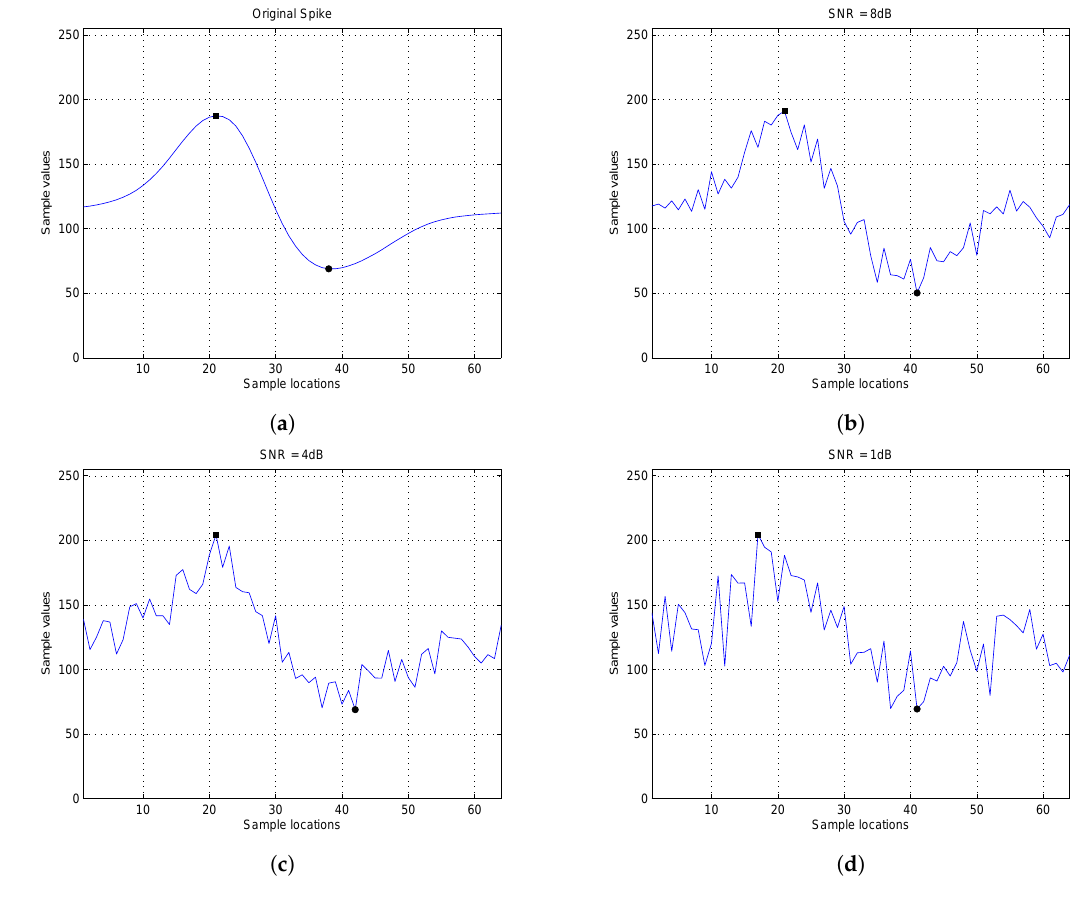
Figure 1. The locations and values of peaks of spikes corrupted by background noises with different SNR levels, where the black square and circle markers represent the maximum and minimum of spikes, respectively. ( a ) The original spike; ( b ) SNR = 8 dB; ( c ) SNR = 4 dB; ( d ) SNR = 1